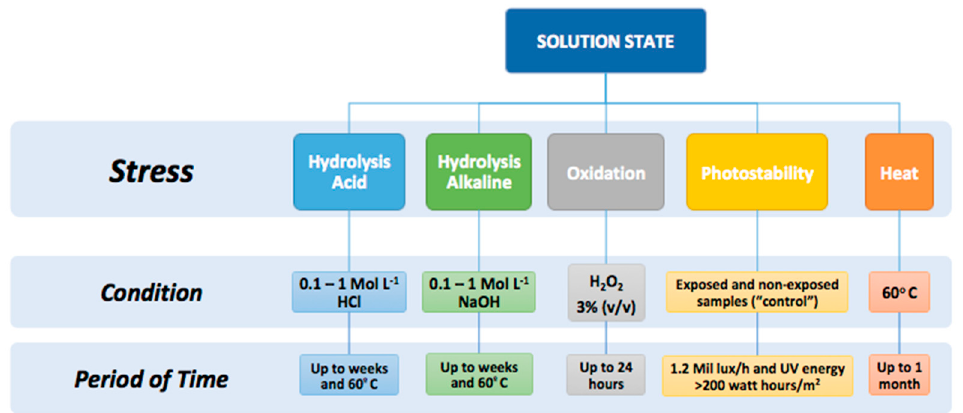
Figure 7. Forced degradation studies. Modified from: [24].